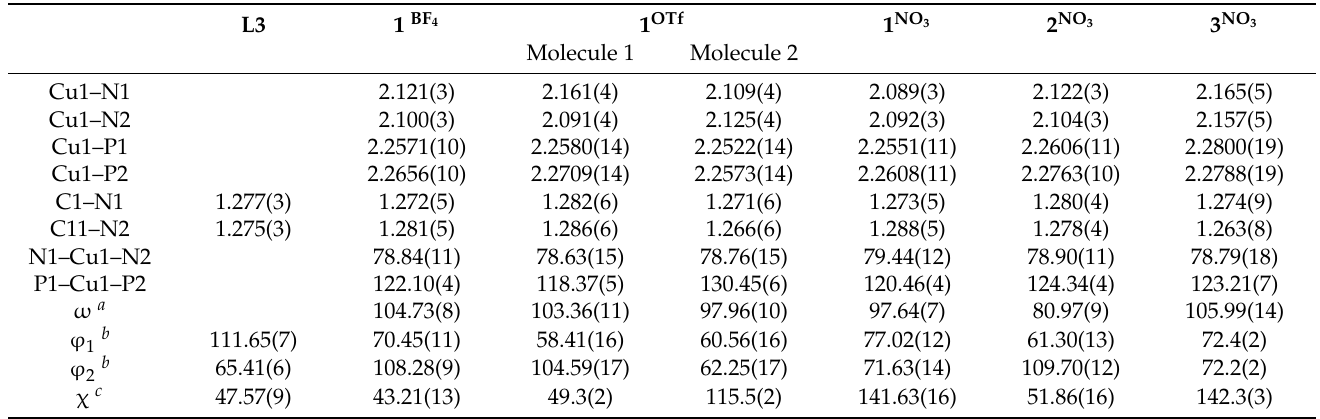
Table 1. Selected bond distances (Å) and angles ( ◦ ), and other relevant structural parameters